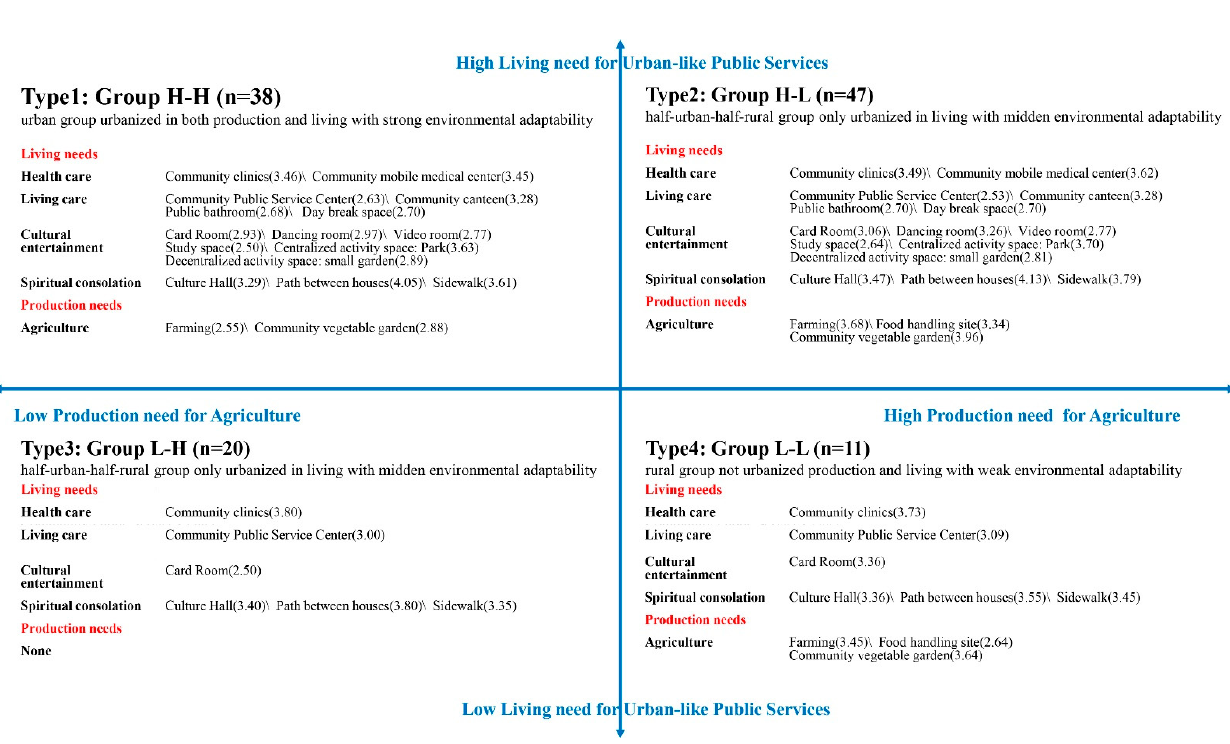
9 of 16 Table 4. Characteristic variables of production needs and One-Way ANOVA test (Source: Author). Production Demand Indicators